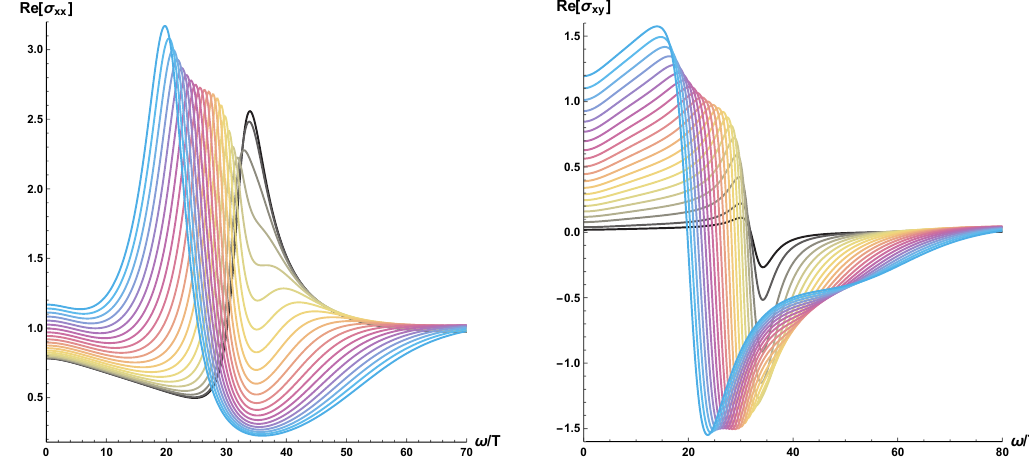
Figure 22 . The evolution of the pseudo-phonon peak increasing the charge density. We move the parameter (cid:26)=T 2 2 [50 ; 2000] (from black to light blue). Other parameters (cid:12) = 1 ; (cid:20)=T = 31 : 4 ; (cid:11) = 0 : 1 ; B=T 2 = 10 3 are kept